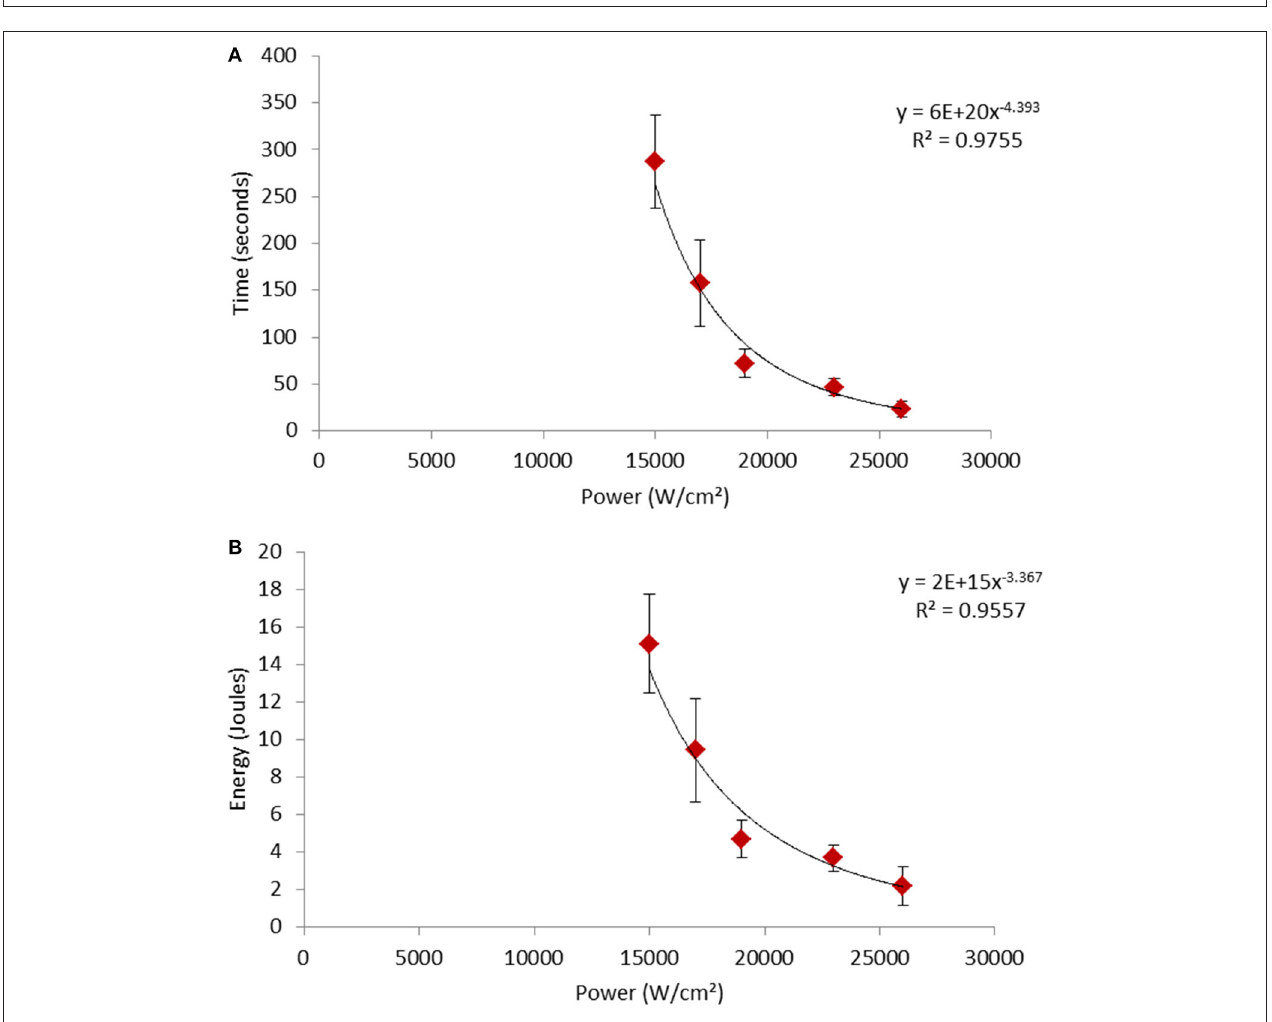
cells was targeted, the production of 1 O 2 was much slower but was still observable at the cellular periphery ( Figure 3B